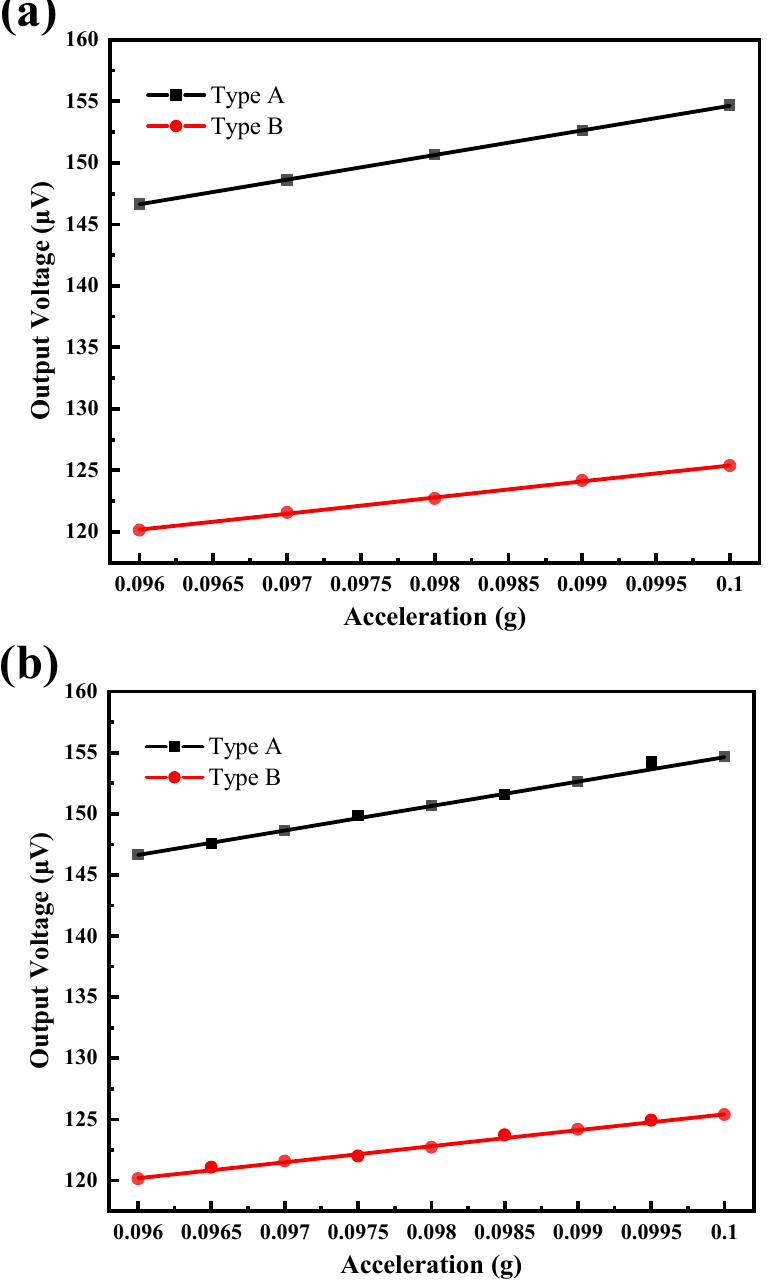
Figure 11. Output voltage vs. acceleration for Type A and Type B piezoelectric accelerometers to obtain the resolution at 400 Hz. Sweep step size of excitation acceleration: ( a ) 1 mg, ( b ) 0.5 mg.